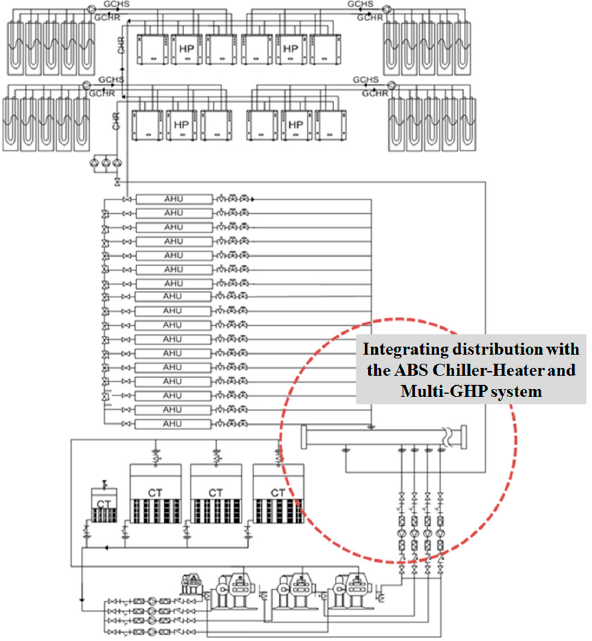
Figure 8. System diagram on the hybrid operation method for GHP system and